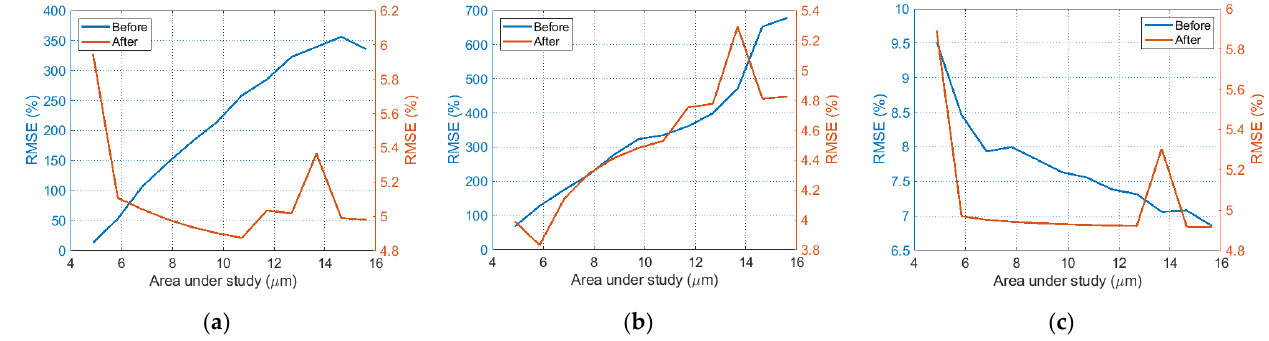
Figure 6. RMSE between depth maps obtained by AFM and SEM for: ( a ) no boundary conditions; ( b ) Neumann boundary conditions; ( c ) Dirichlet boundary conditions.